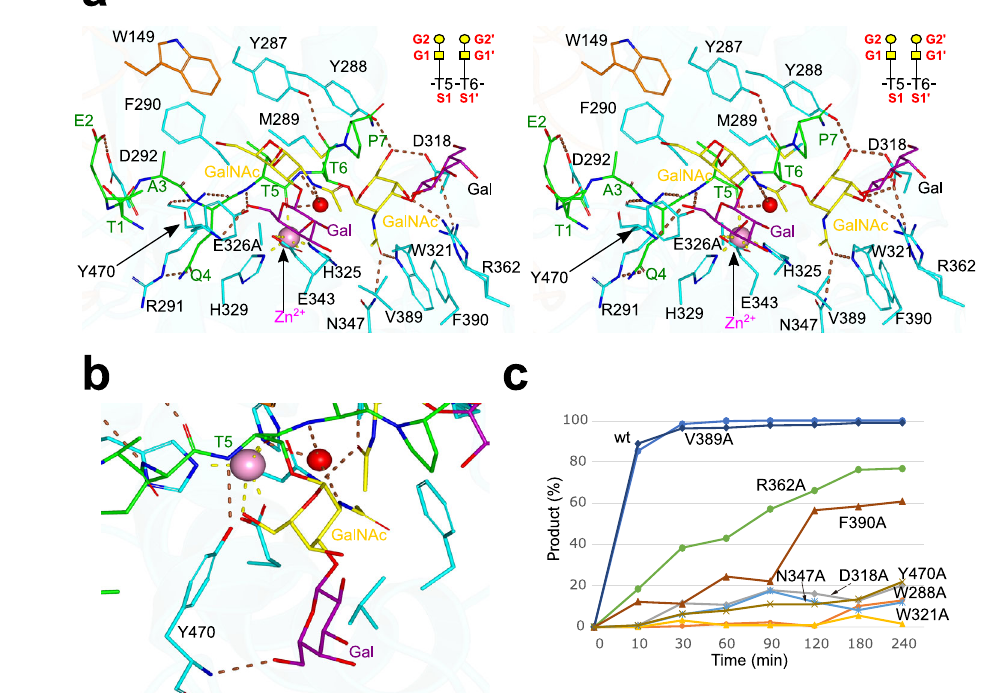
Fig.3|Structuralfeaturesoftheactivesite.a Stereoviewoftheactivesiteforthe AM0627 E326A – P1 – Zn 2+ complex.Theresiduesformingtheactivesitearedepictedas cyan(catalyticdomain)andorange(IgG-folddomain)carbonatoms.Therestofthe colors for the metal, the water molecule, and the dotted lines for the hydrogen bond interactions are the same as described in Fig. 2 . The GalNAc moieties are displayedinyellowaccordingtotheSNFG 60 ,whiletheGalmoietiesaredisplayedin magenta for illustration purposes. The inset shows a scheme of the subsite nomenclaturefortheaminoacidsandthesugarmoietiesof P1 .Notethatthesugar moieties in the inset are displayed in yellow and with different symbols according to the SNFG. b Alternative close-up view of the active site to highlight the